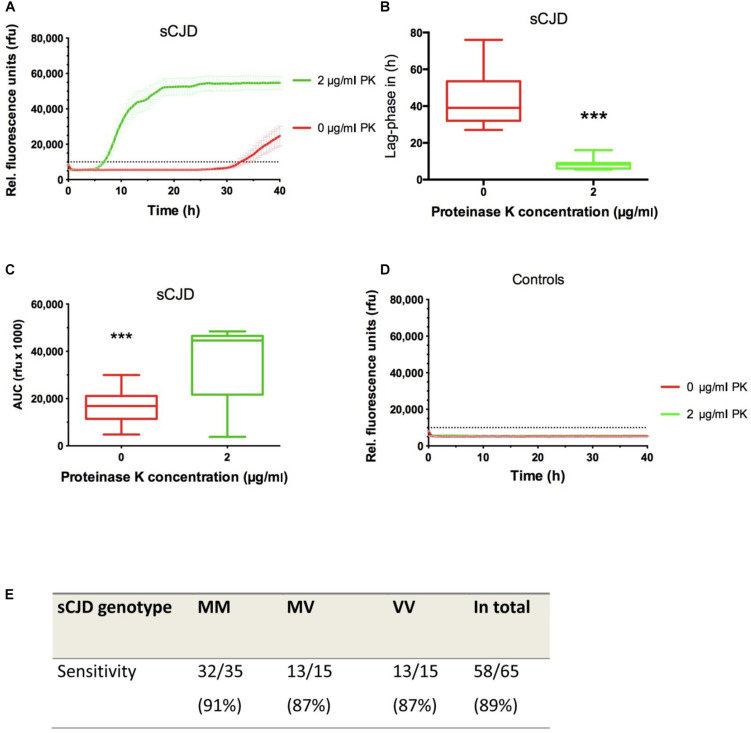
Optimization of the CSF RT-QuIC. (A) RT-QuIC reactions terminated at 40 h and seeded with sCJD MM CSF (n = 20) were treated with 2 μg/ml of PK, which increased the conversion efficiency of PrP significantly as indicated by a shorter lag phase (B) and a higher relative area under the curve (AUC) value (C). Non-prion disease controls (n = 20) remained negative (D). (E) In a retrospective study, we analyzed the sensitivity of the RT-QuIC after PK (2 μg/ml) treatment in different sCJD codon 129 MV genotypes showing an average sensitivity of 89% for all sCJD codon 129 MV genotypes. RT-QuIC responses were measured in rfu over a period of 40 h. Displayed are means ± SEM (standard error of the mean) at each point in time. p values: <0.001 as extremely significant (***).